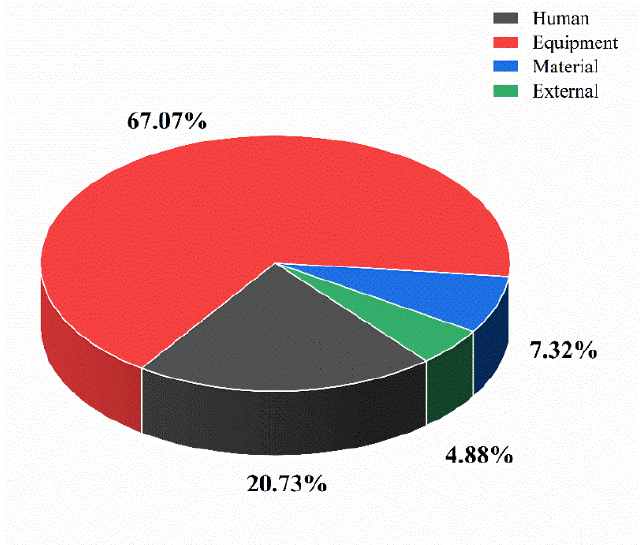
Figure 9. Accident causes statics.